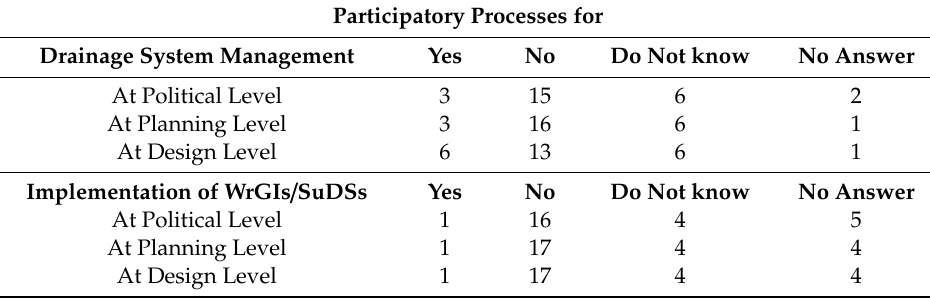
Table 2. Use of participatory processes in decision-making for drainage system management and the set-up of WrGIs /